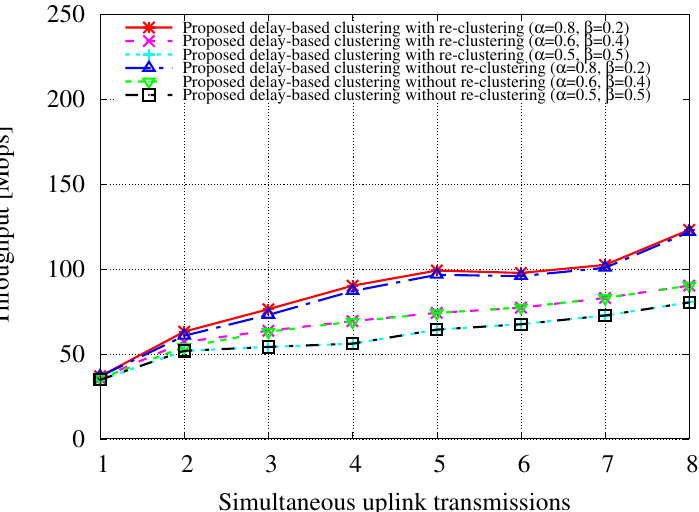
Figure 11. Network throughput performance (MCS of 80% stations changes, λ = 1.9).